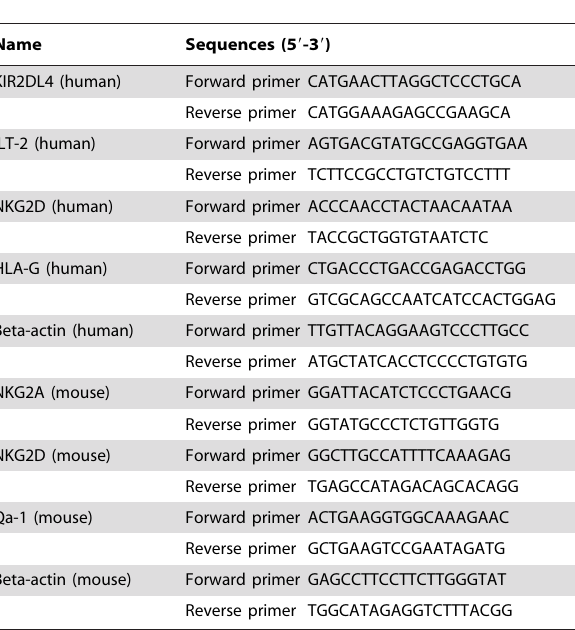
Table 1. Sequences